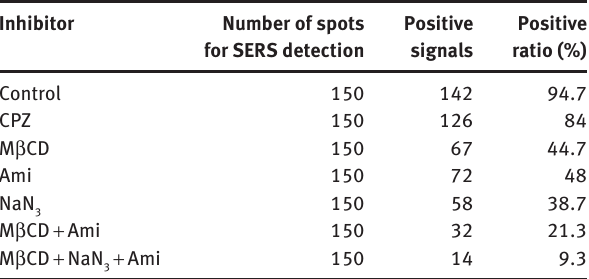
Table 1: Effect of inhibitors on the uptake of BP-Au NSs into HepG2 cells measured by SERS